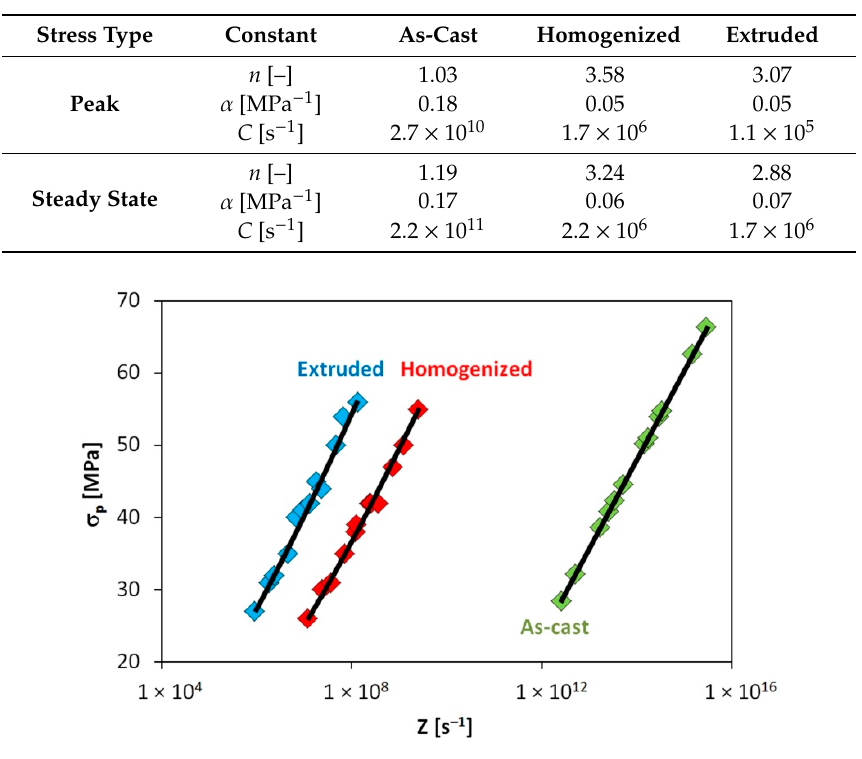
Figure 11. Dependence of measured and calculated values of σ p on the Zener-Hollomon parameter and the initial structural state.